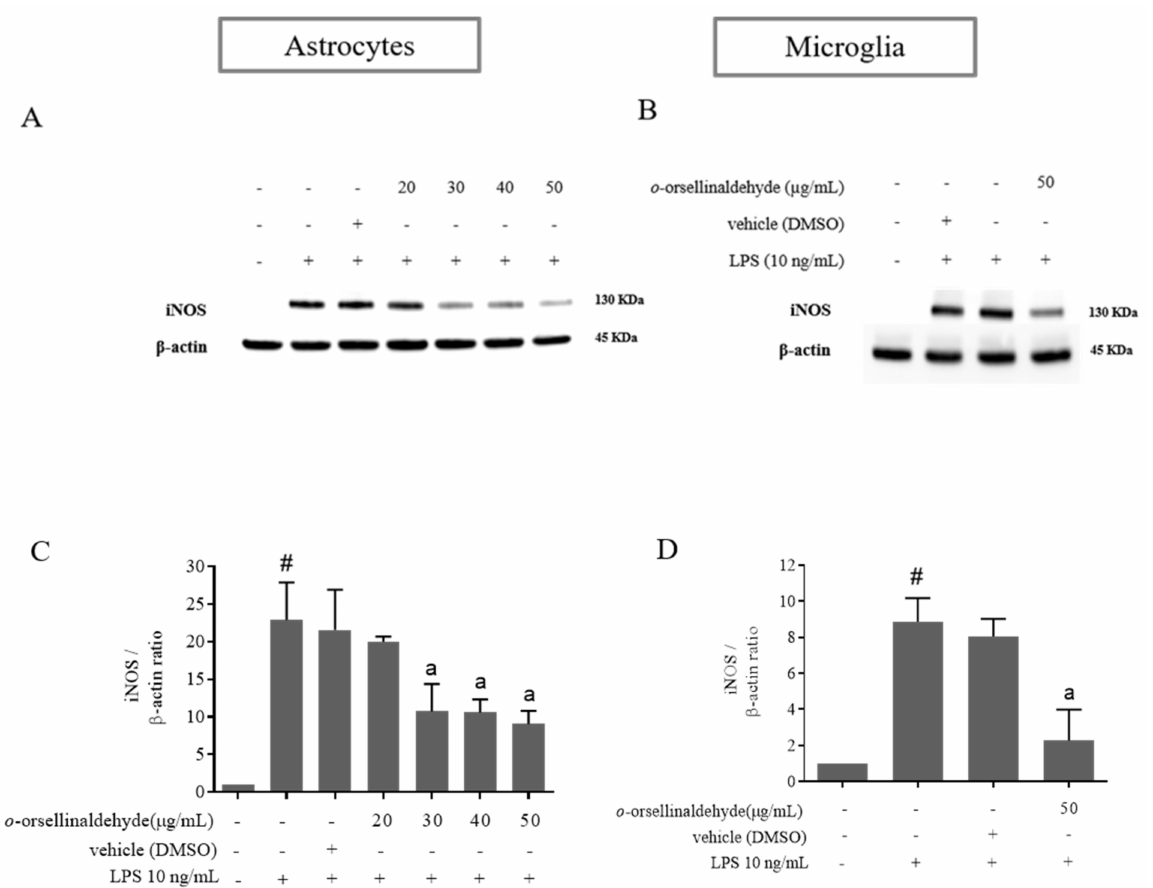
Figure 4. o -Orsellinaldehyde downregulates iNOS protein expression in LPS-challenged astrocytes and microglia cells. Cells were incubated with the indicated concentrations of o -orsellinaldehyde for 30 min before treatment, and with LPS (10 ng/mL) for 24 h. The cell pellet was collected for iNOS measurement by Western blot. ( A ) Representative image of iNOS Western blotting in astrocytes. ( B ) Representative image of iNOS Western blotting in microglia. ( C ) Densitometry plot of Western blots carried out in astrocytes. ( D ) Densitometry plot of Western blots carried out in astrocytes. Results are shown as the mean ± SD of four independent experiments. Statistically significant differences ( p ≤ 0.05) of LPS compared to the control condition are expressed as a “#”. Statistically significant differences ( p ≤ 0.05) between LPS conditions are expressed with an